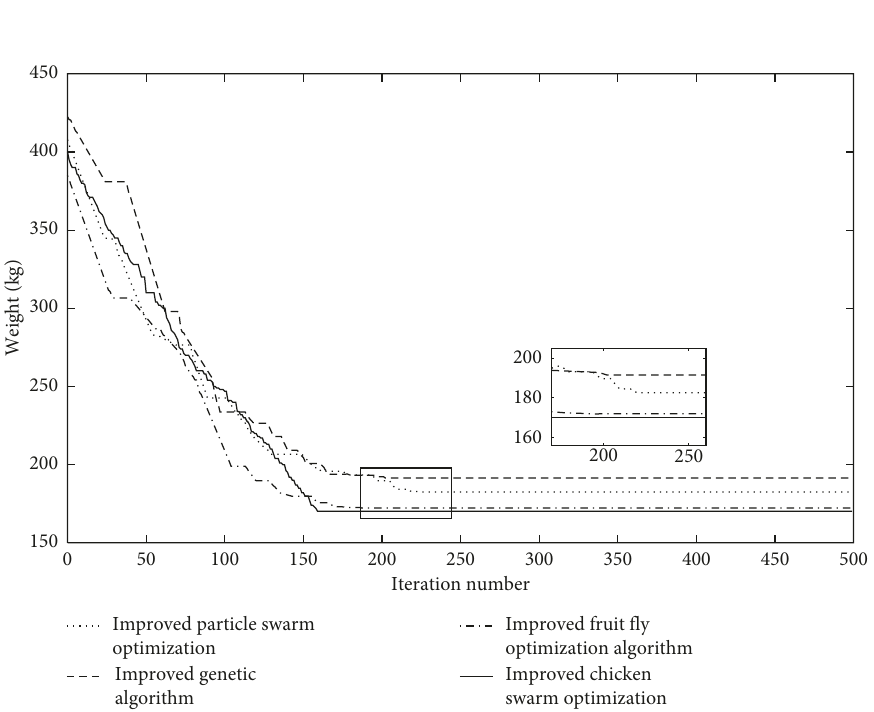
Figure 12: Four algorithms for finding the iterative curve of 72bars.